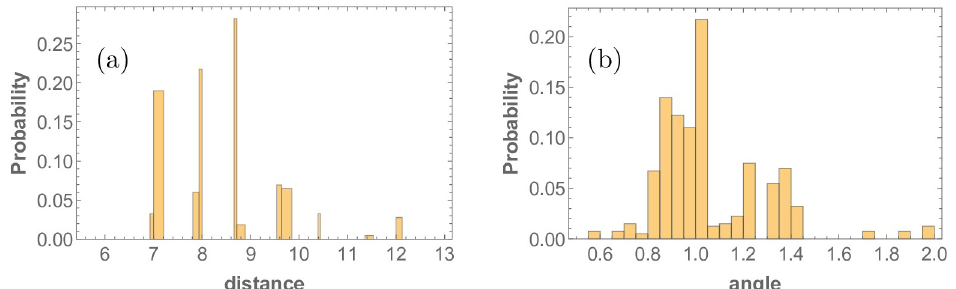
Fig 6. Nearest neighbor (a) distance and (b) angle probability distributions of R8 cell point pattern in the Drosophila eye disc in the absence of stochasticity. Distances are naturally binned by the available sites on the underlying hexagonal lattice, whereas angular positions are collected in bins of 0.05